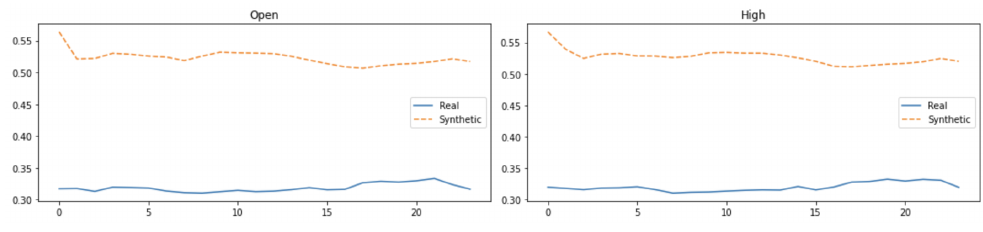
Figure 7. Synthetic and real data for open and high columns.